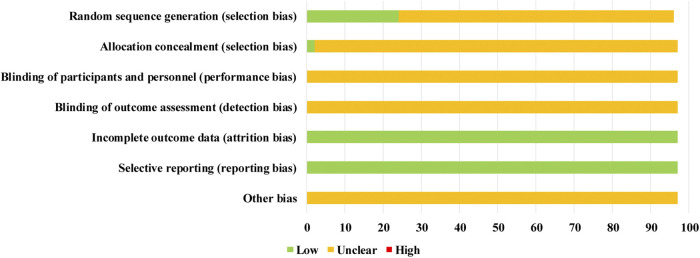
Risk of bias graph.